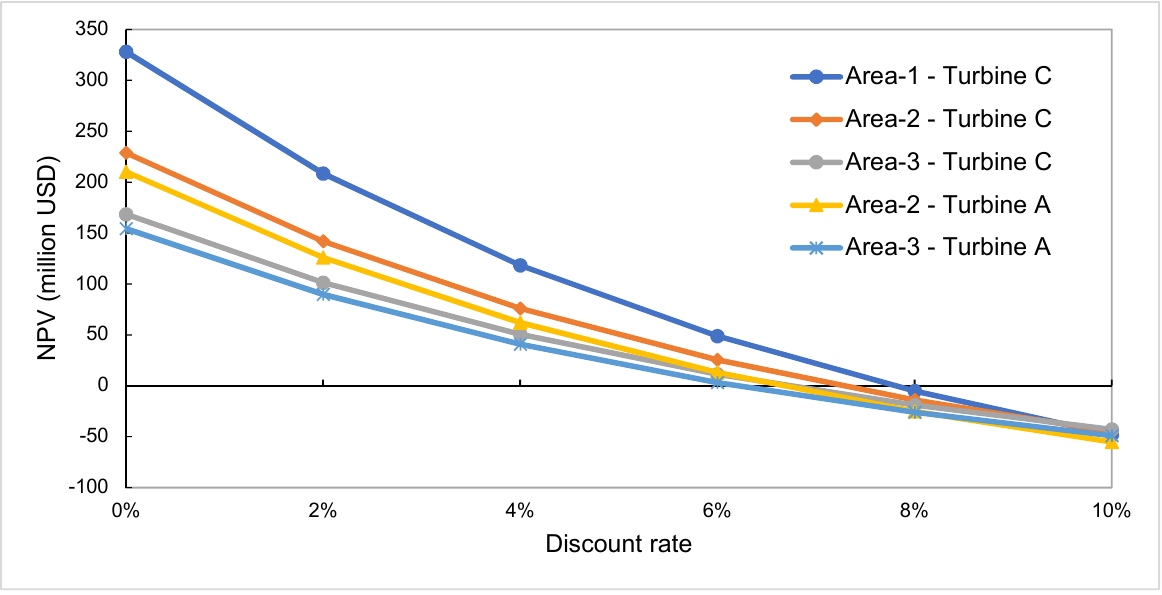
Figure 14. Sensitivity of NPV for different discount rates at the proposed wind farms off Wetar Island. LCOE for various wind farm sizes off Wetar Island indicated that LCOE slightly increased as farm size dwindled. The lowest LCOE was 0.082 USD/kWh for the turbine C in Area-1, followed by 0.085 USD/kWh in Area-2. Turbine A had slightly higher LCOE than turbine C did, whereas turbine B had substantially higher LCOE. The lowest LCOE at 0.082 USD/kWh was still higher than the FIT for wind power in Indonesia at 0.08 USD/kWh. A higher FIT would be required for Indonesia to draw investment in wind energy.